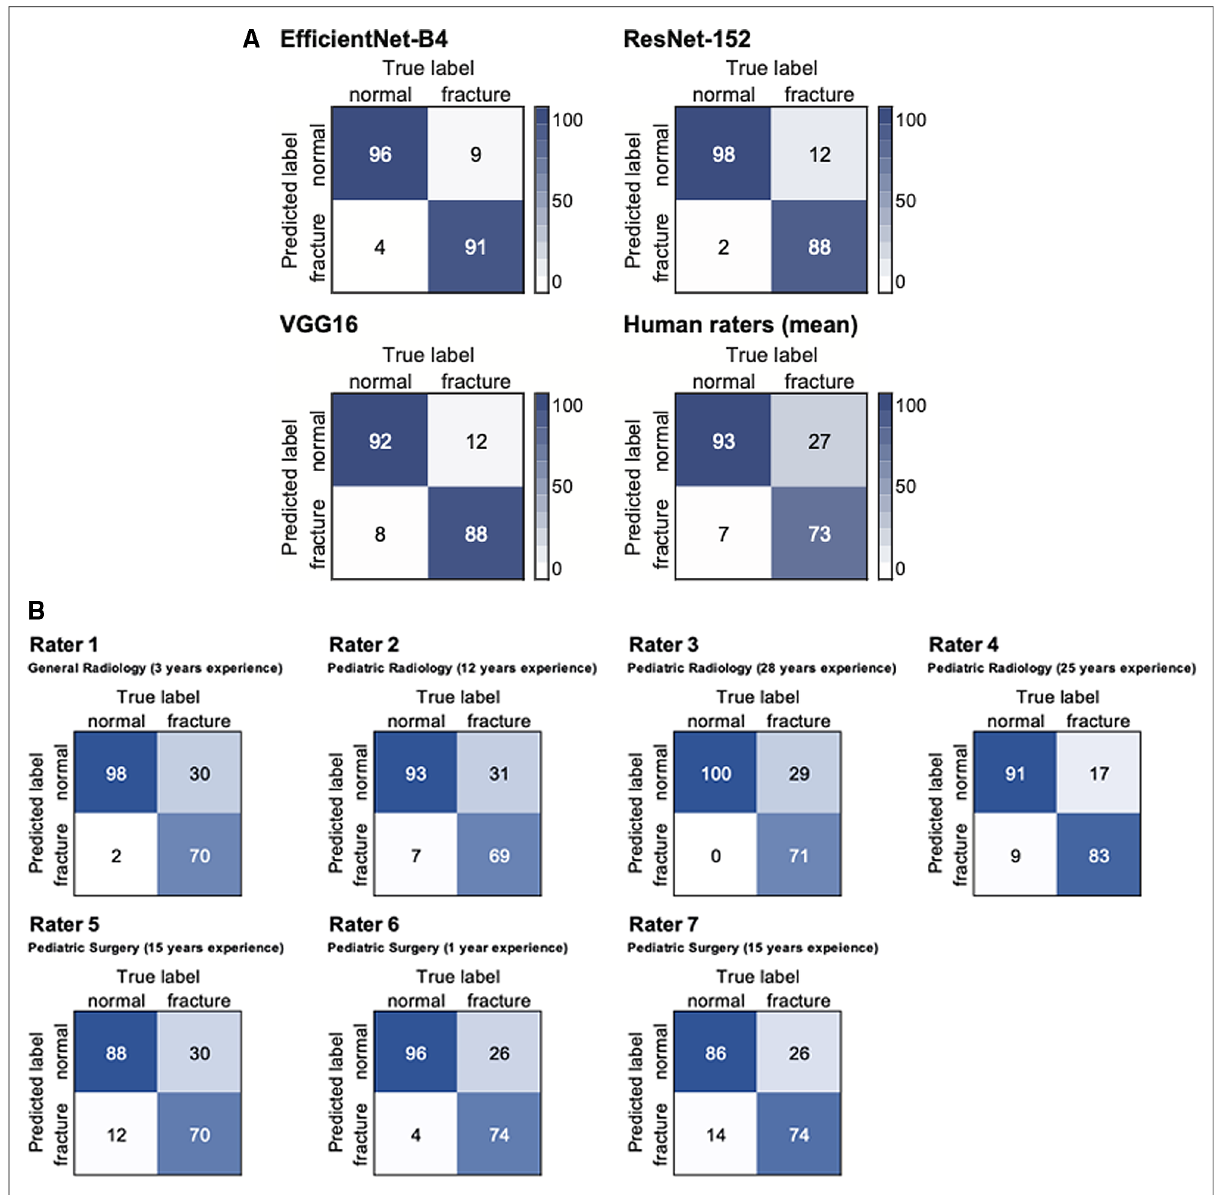
FIGURE 3 Confusion matrices of the test dataset ( n =200) for CNN models and the mean rating of human experts ( A ) as well as individual performances ( B